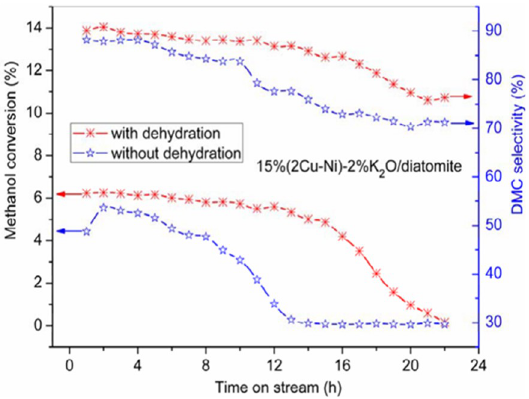
Figure 9. Stability study of the catalyst evaluated with or without dehydration.